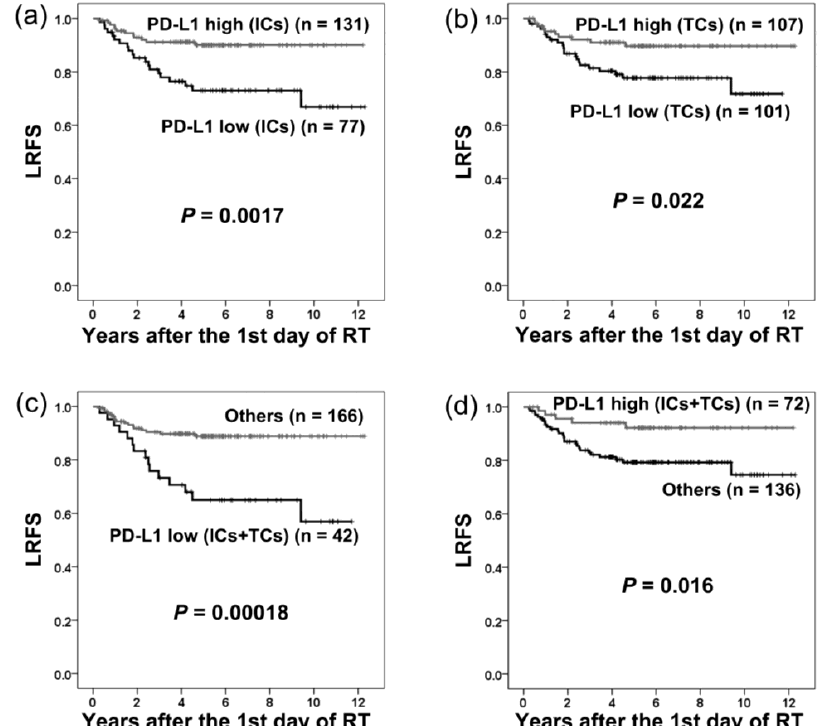
Figure 2. Local recurrence-free survival (LRFS) in patients with different levels of PD-L1 expression on immune cells (ICs) and tumor cells (TCs). There was significantly shorter LRFS in patients with low PD-L1 expression on ICs ( a ), TCs ( b ), or both ICs and TCs ( c ). Significantly longer LRFS was observed in patients with high PD-L1 expression on both ICs and TCs ( d